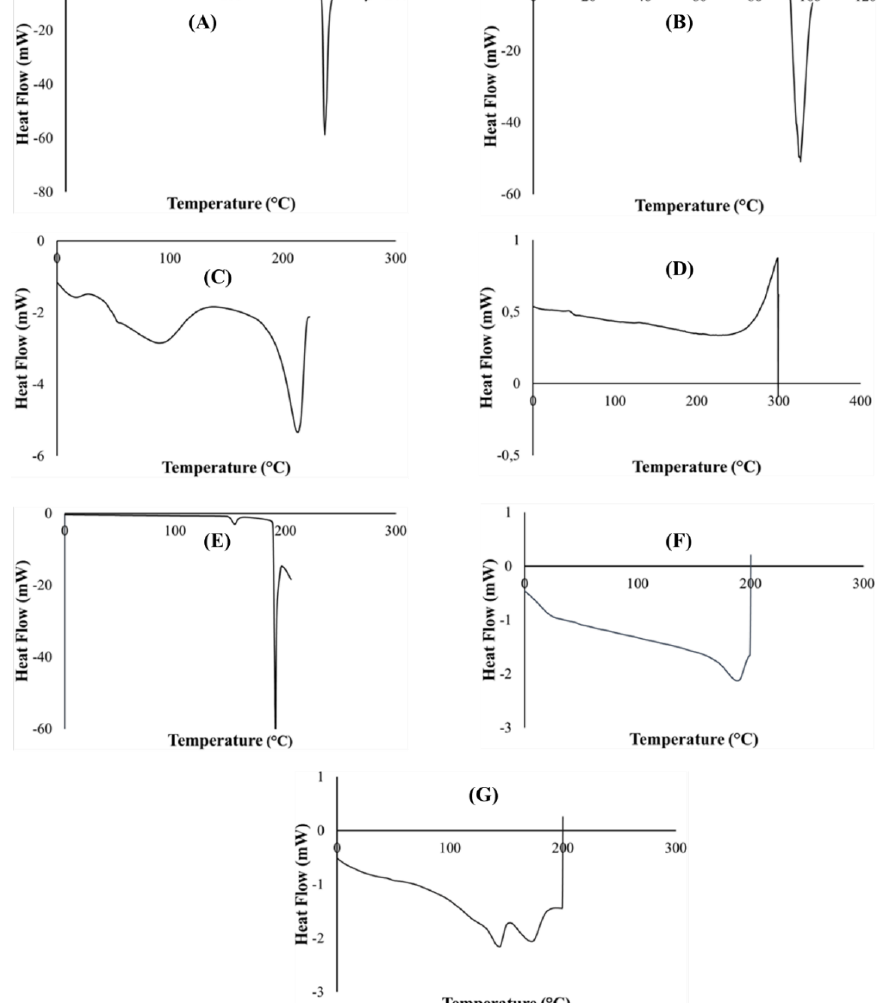
Figure 3. DSC Thermograms of ( A ) citric acid, ( B ) xylitol, ( C ) polyvinyl alcohol polyethylene glycol, ( D ) sodium starch glycolate, ( E ) pyrazinamide, ( F ) placebo and ( G ) drug loaded formulation.